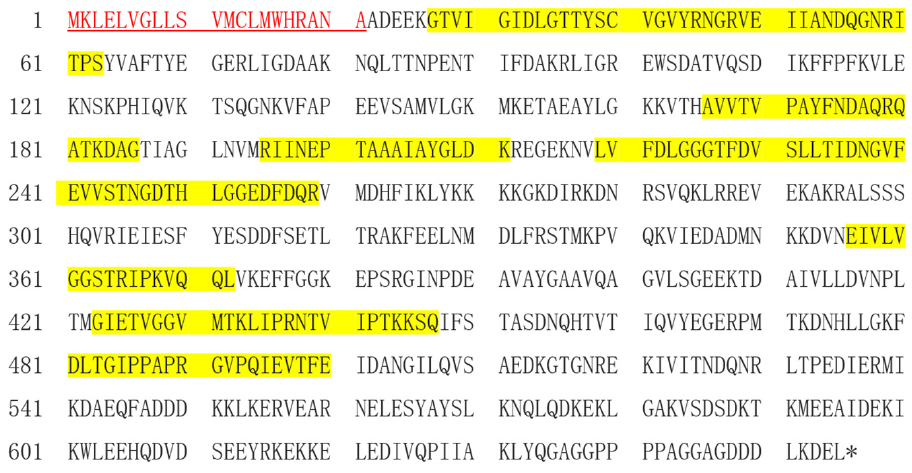
Figure 1. Amino acid sequence of NlHSC70-3. Signal peptide is written in red. The asterisk indicates the stop codon. The highlighted yellow amino acid residues indicate the peptides detected in BPH-infested rice tissue by liquid chromatography-tandem mass spectrometry